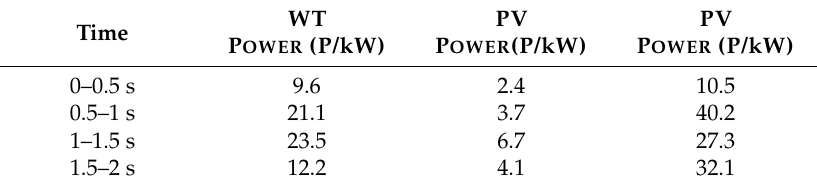
Table 3. Simulation conditions.